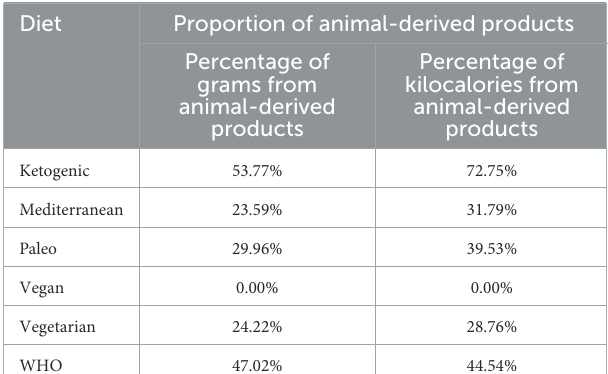
TABLE 2 Proportion of grams and kilocalories in each diet from animal-derived products (including meat, dairy, eggs, honey, and similar), for 1 week of food at 2,000